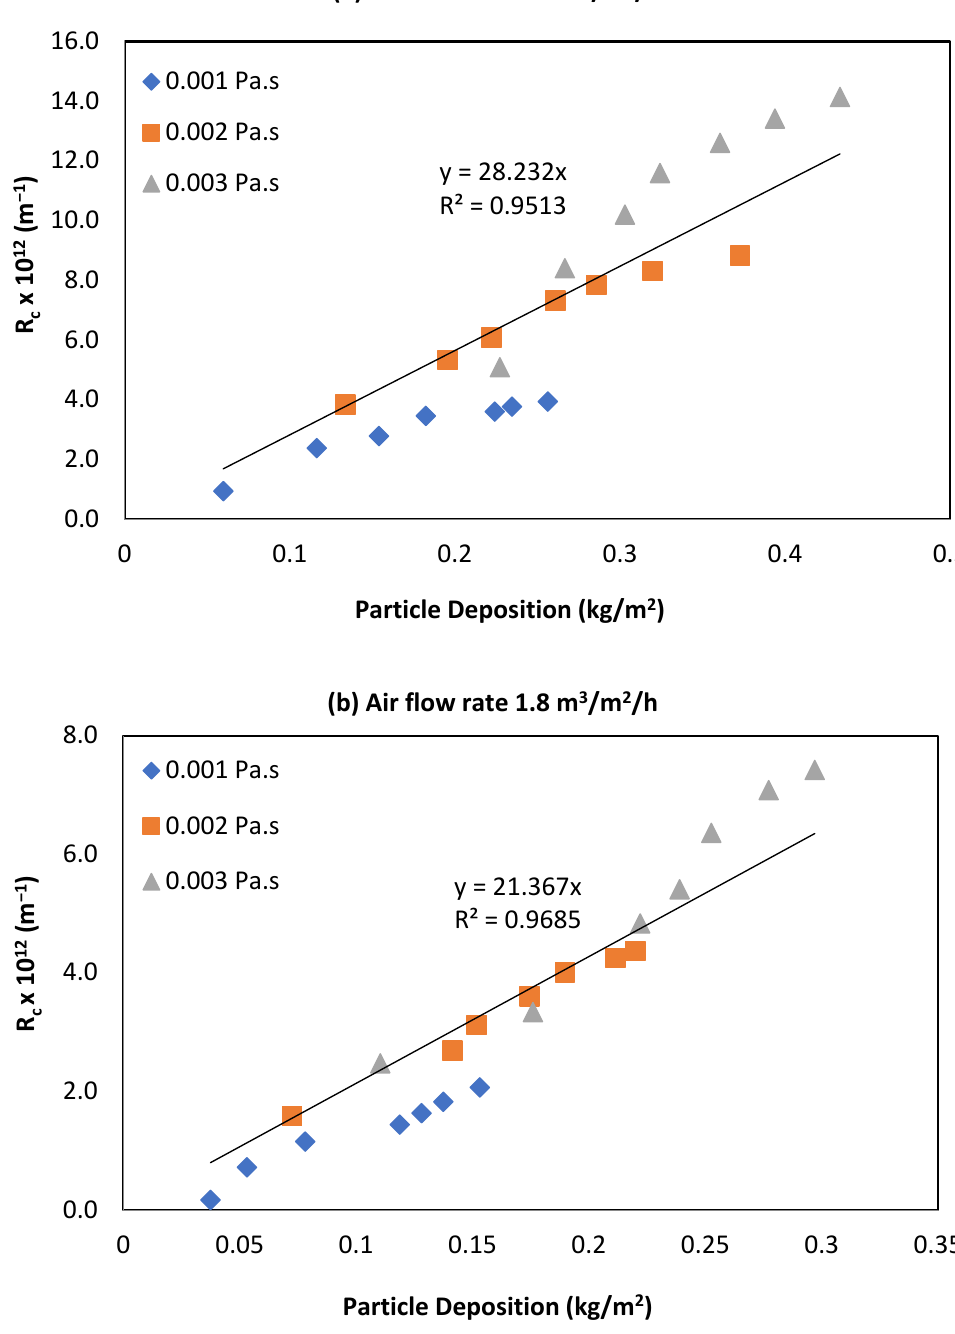
Figure 5. Relationship between R c and particle deposition at 15 L/m 2 /h and two airflow rates.